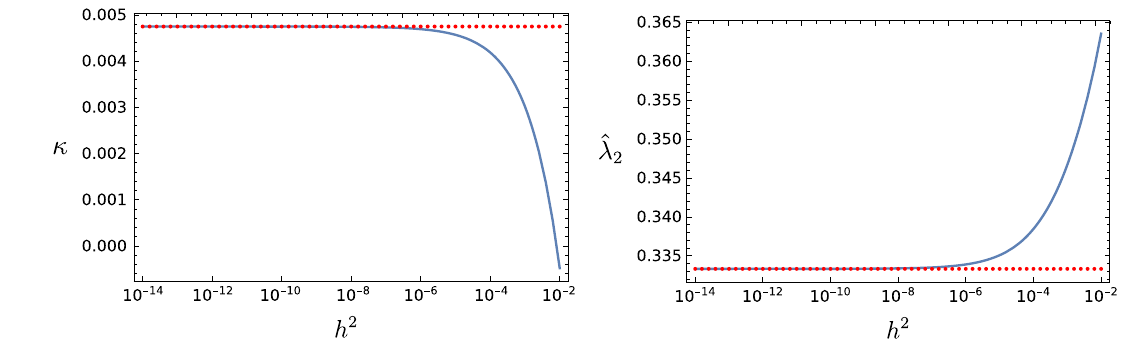
Fig. 4 Effective field theory analysis including thresholds for the case P = 1 / 4. We plot the full numerical solutions κ